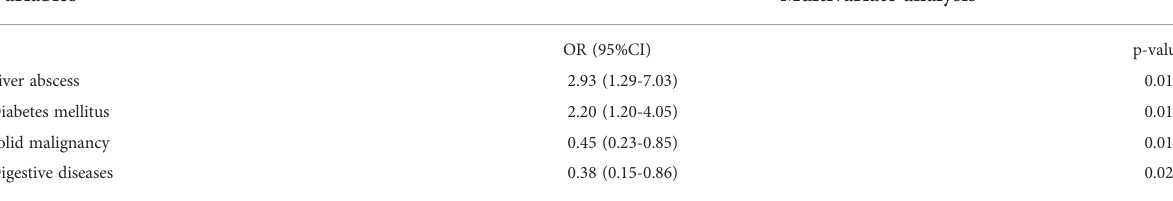
TABLE 2 Clinical risk factors for HmKp infection identi fi ed by logistic